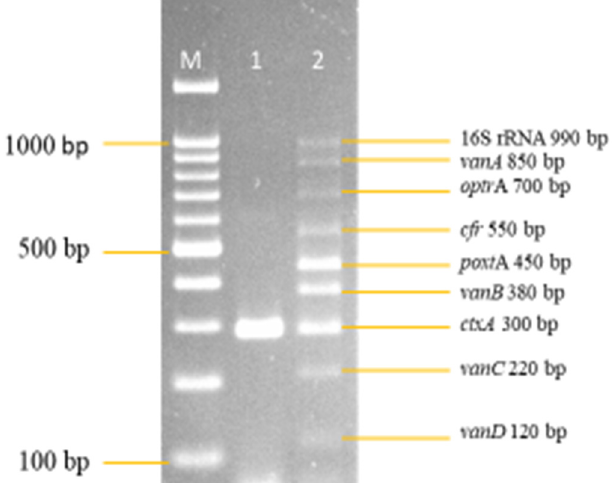
Figure 2. Final optimized multiplex PCR primer concentration. All other PCR parameters remained unchanged. Lanes M: DNA ladder 100 bp plus. Lane 1: Negative control with ctxA (Internal control). Lane 2: Optimized multiplex primer concentration. 16S rRNA = 1.0 pmol/ μ L. vanA = 1.0 pmol/ μ L. optrA = 1.0 pmol/ μ L. cfr = 1.0 pmol/ μ L. poxtA = 0.1 pmol/ μ L. vanB = 0.08 pmol/ μ L. ctxA = 0.07 pmol/ μ L. vanC = 0.8 pmol/ μ L. vanD = 0.1 pmol/ μ L.